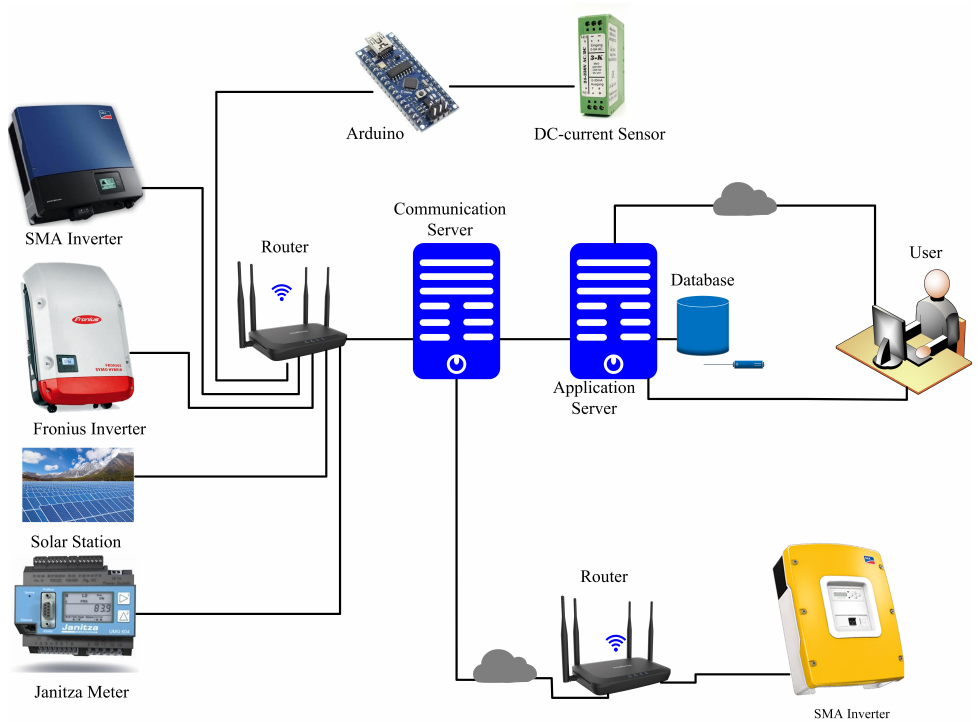
Figure 5. Proposed structure for the data acquisition and supervisory system including the data flow path , field devices, router of the control room, application system, and the database.